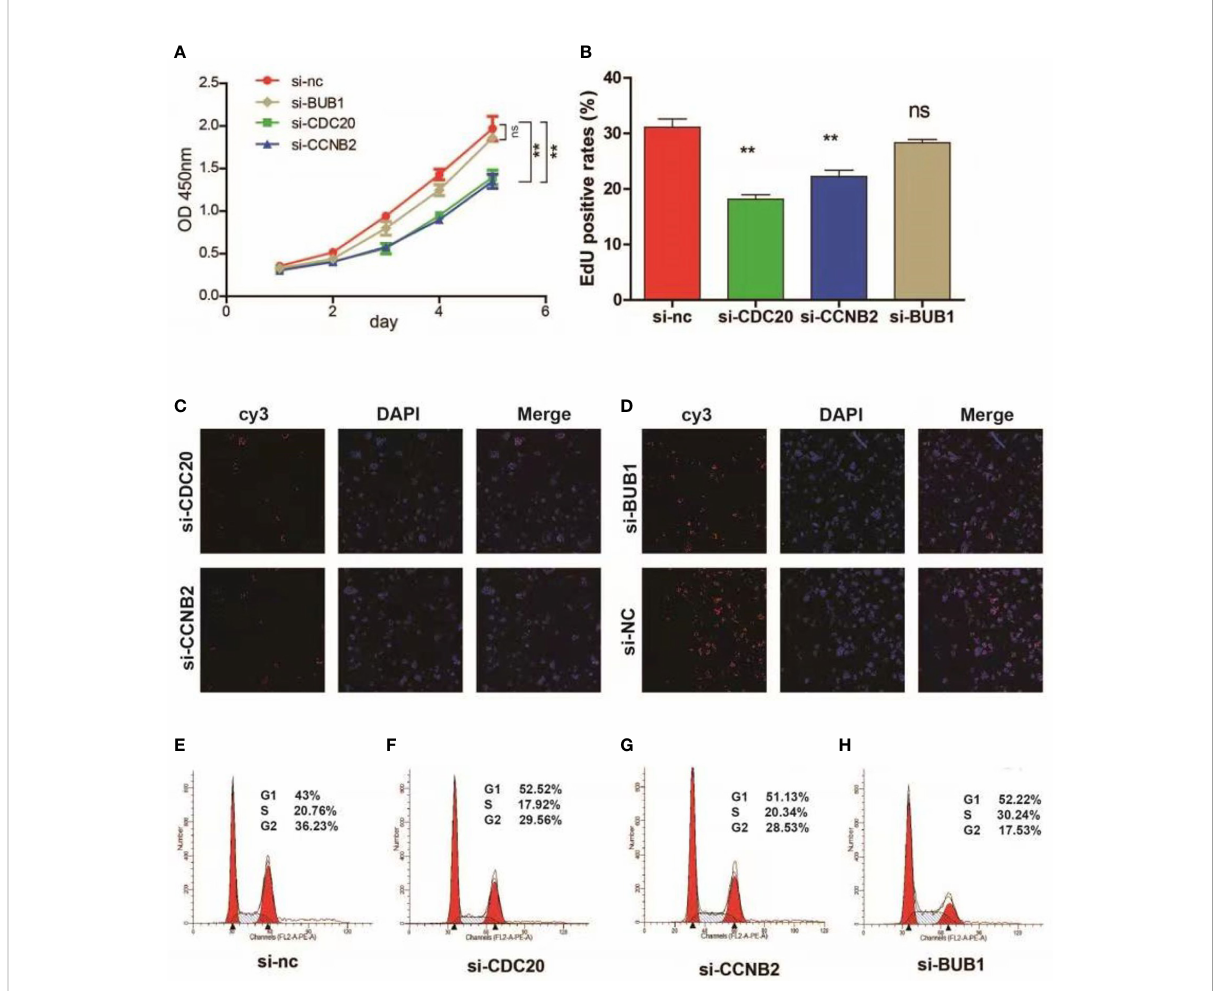
FIGURE 5 CDC20, CNNB2, and BUB1 affects the proliferation of SK-NEP-1 cells. (A-D) The cell proliferative ability was assessed by the Cell Counting Kit-8 (CCK-8), and EdU assay after CDC20, CNNB2, and BUB1 was knocked down in SK-NEP-1 cells. (E-H) Down-regulation of CDC20, CNNB2, and BUB1 arrests the cell cycle of SK-NEP-1 cells(**P < 0.01, ns, none